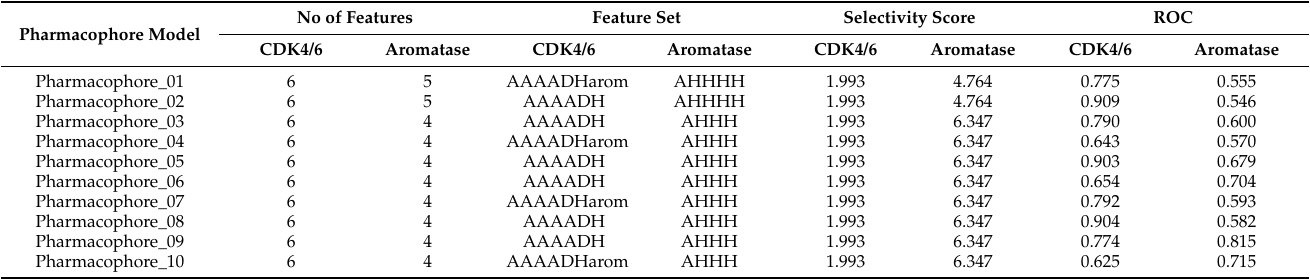
Table 1. Structure-based pharmacophore model hypothesis with their features and